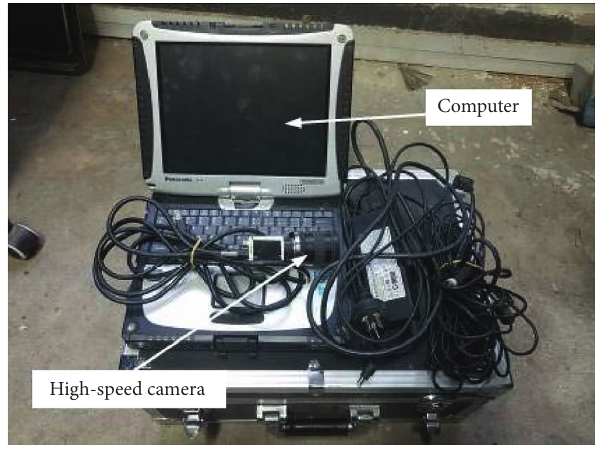
High-speed camera Figure 10: PIV